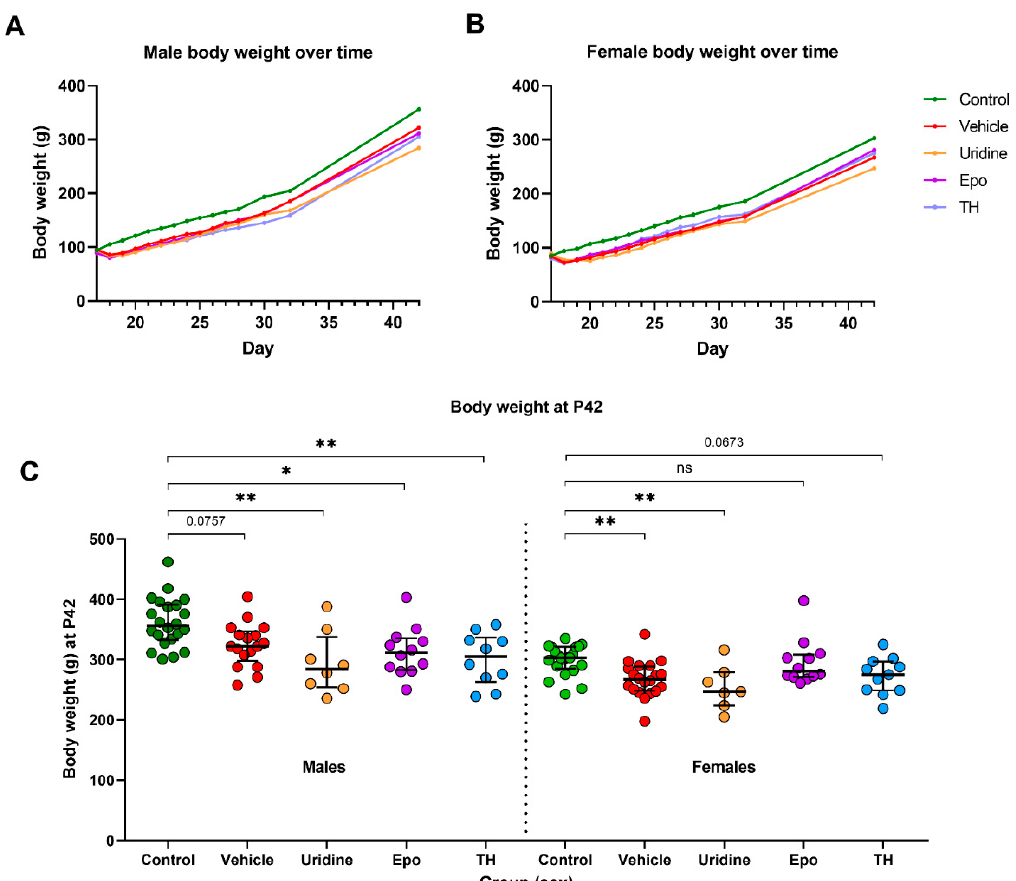
Figure 1. Body weight analysis. ( A ) At P42, all Ur animals were significantly lighter than control animals. In the males, the other HIH animals were also lighter than the controls; however, the comparison between control males and Veh males was not significant. In the females, the Veh animals were significantly lighter than the control animals, but TH and Epo animals were more comparable to the control animals. ( B ) On the day of HIH (P17), mean (SD) weight of the male kits was 93.0 (7.8) g. On average, HIH males lost 9.6% (7.1%) of their body weight between P17 and P18 as a result of the HIH insult. By P19, HIH males gained 2.0% (6.9%) of their P17 body weight back, compared to a 26.7% (6.0%) weight gain in controls by P19. The HIH males never fully recovered from the weight loss that followed HIH, but the difference in weight between Veh males and control males on P42 lost its significance. ( C ) At P17, the mean weight of the female kits was 83.3 (5.6) g. On average, HIH females lost 11.3% (8.3%) of their body weight between P17 and P18 as a result of the HIH insult. By P20, HIH females gained 4.4% (13.5%) of their P17 body weight back, compared to a 25.2% (9.0%) weight gain in controls by P20. The HIH females took an extra day longer to gain back the P17 body weight deficit when compared to the HIH males, but the HIH females maintained a weight gain pattern more consistent with the control females by P42. * Denotes p –value < 0.05, ** denotes p –value < 0.01, and ns denotes no significant difference.